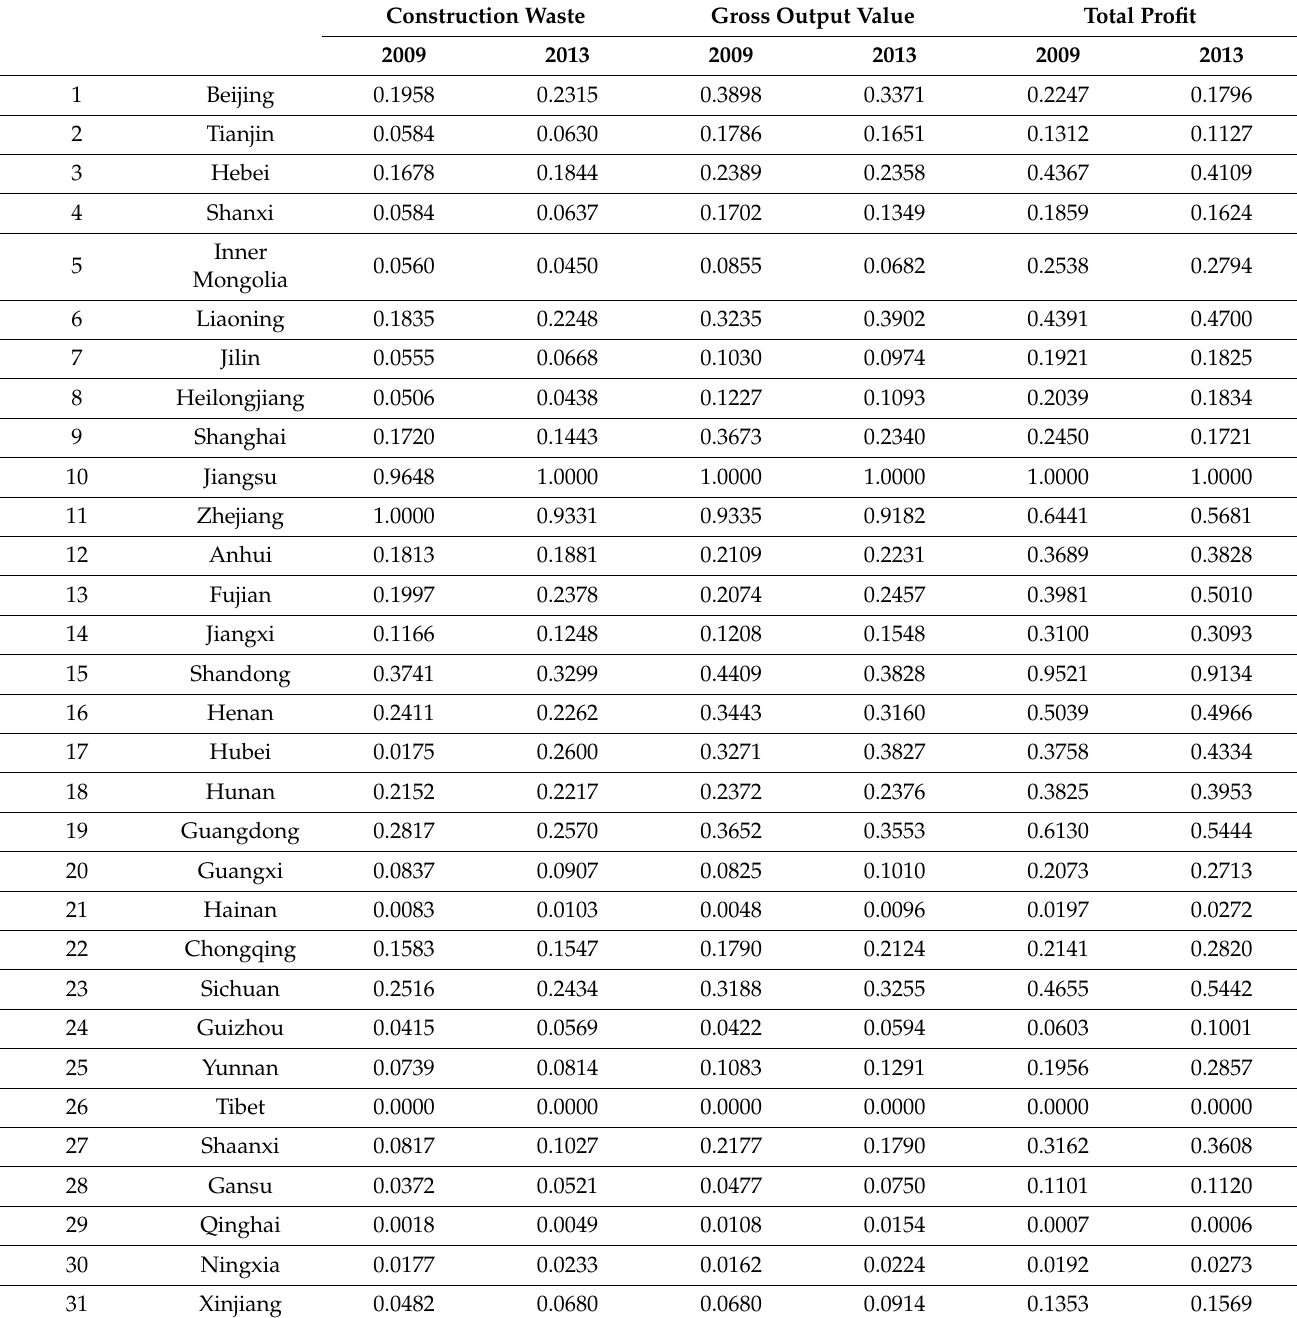
Table A3. Standardized and normalized raw data in 2009 and